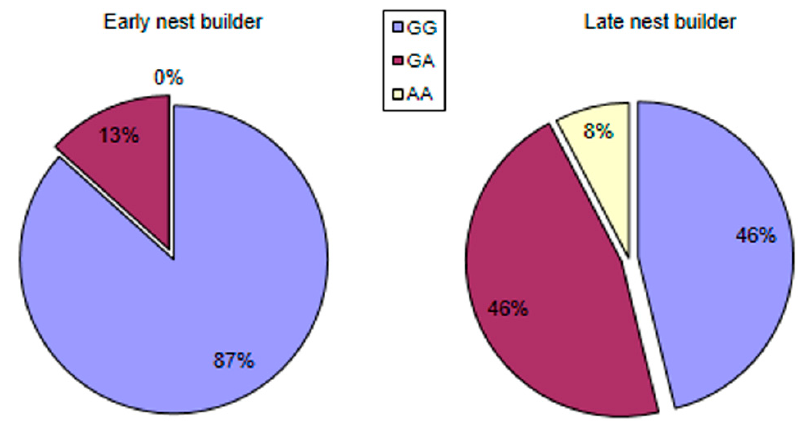
Figure 2. Distribution of the PRG 2464G > A SNP genotypes in the groups clustered by the time when hay collecting started.